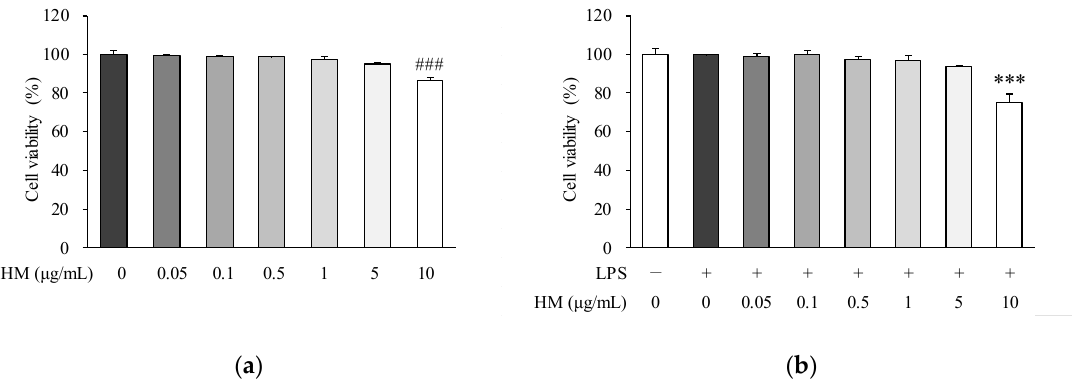
Figure 2. Effect of HM on cell viability in RAW264.7 cells. Cells were treated ( a ) without or ( b ) with 1 µ g/mL of LPS and HM (0.05, 0.1, 0.5, 1, 5, and 10 µ g/mL) for 24 h. Cell viability was assessed using the water-soluble tetrazolium salt (WST)-8 assay. Values are expressed as mean ± standard error of the mean (SEM) ( n = 3). ### p < 0.001 vs. untreated. *** p < 0.001 vs. LPS-treated control. LPS, lipopolysaccharide; HM, high hydrostatic pressure extract of mulberry fruit.